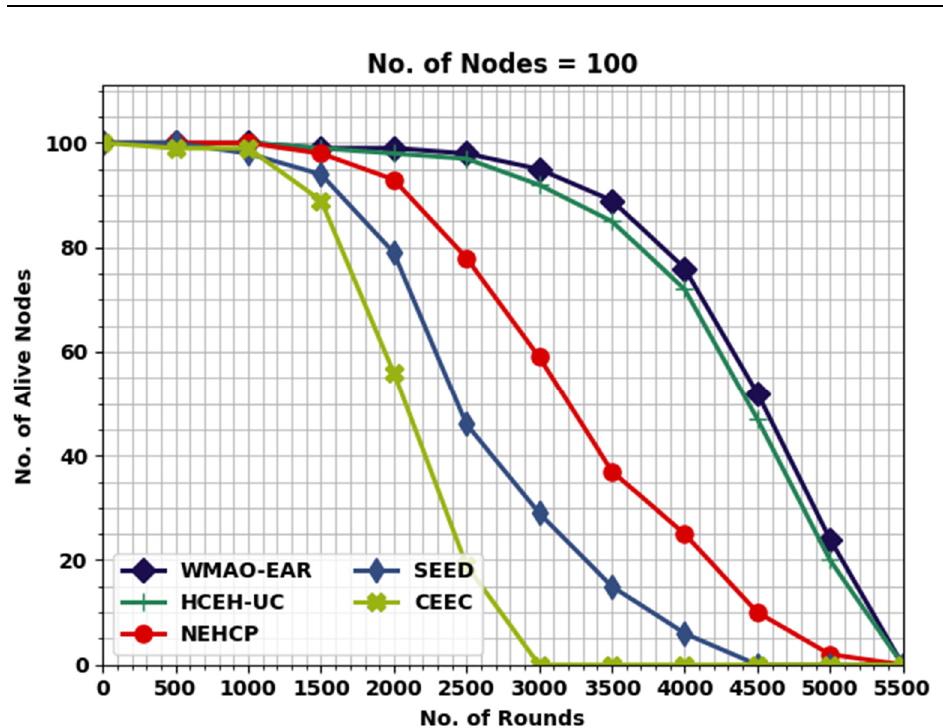
Figure 7. NOAN analysis of WMAO-EAR approach under NC of 100. Figure 8 illustrates the comparative NOAN study of the WMAO-EAR approach. With 2000 rounds, the NOAN rendered by the WMAO-EAR technique is 300, whereas the CE-EC, SEED, NEH-CP, and HCEHUC methods attained reduced NOAN of 295, 277, 257, and 216, respectively. With 2500 rounds, the NOAN granted by the WMAO-EAR model is 298, whereas the CE-EC, SEED, NEH-CP, and HCEHUC approaches achieved